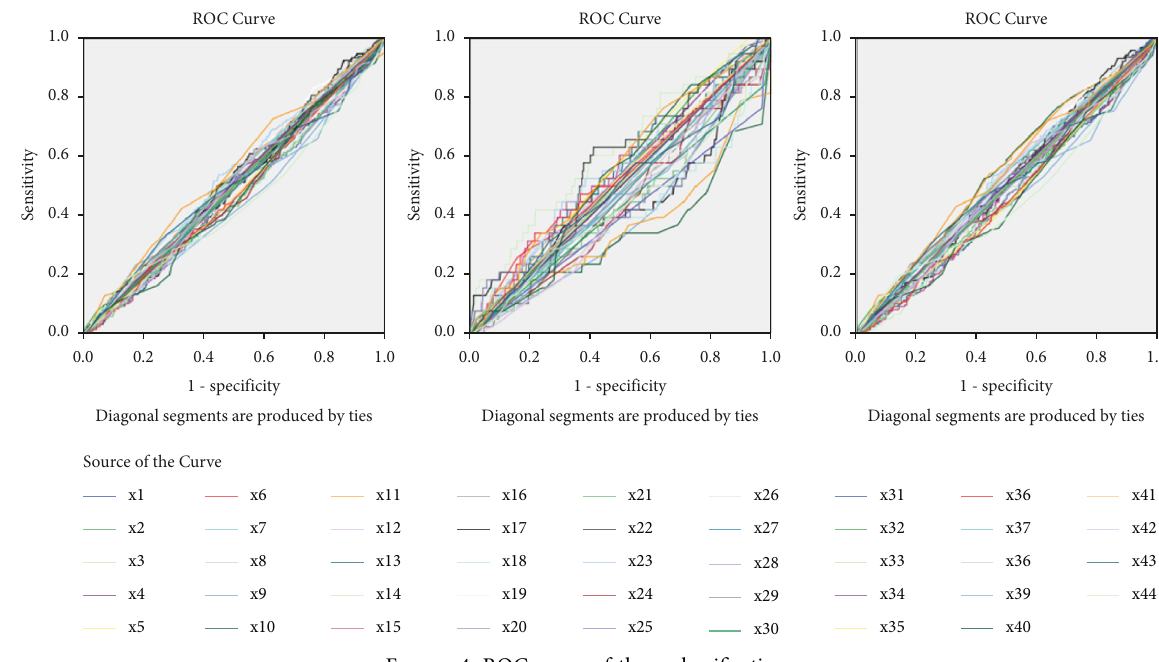
Figure 4: ROC curve of three classifications.